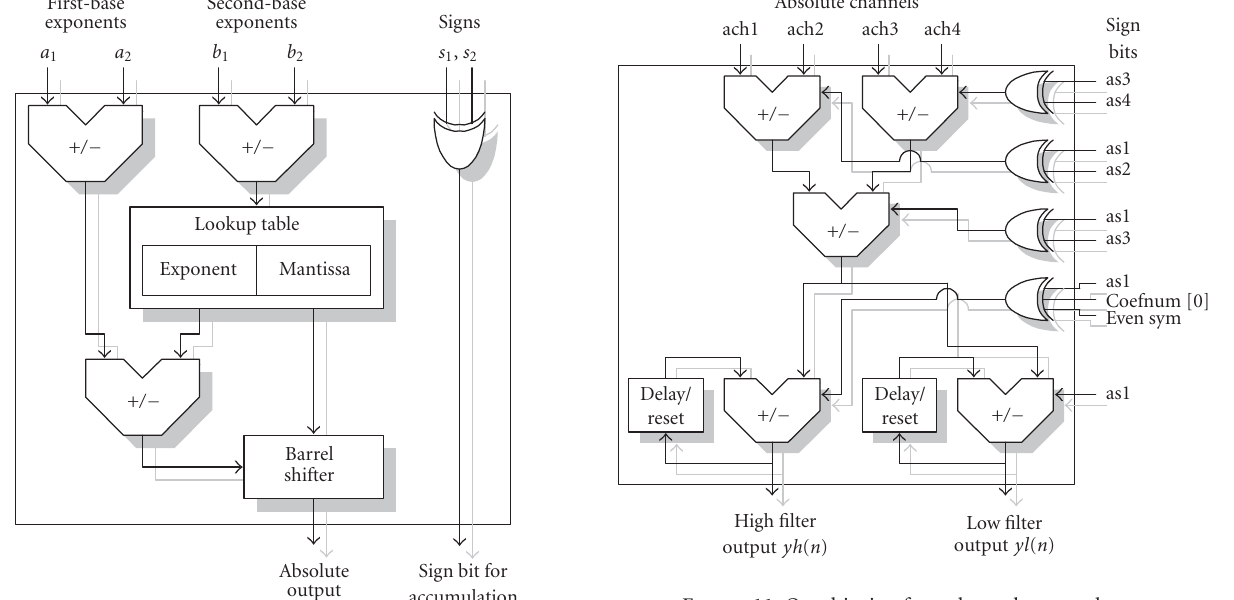
Figure 11: One-bit sign four-channel